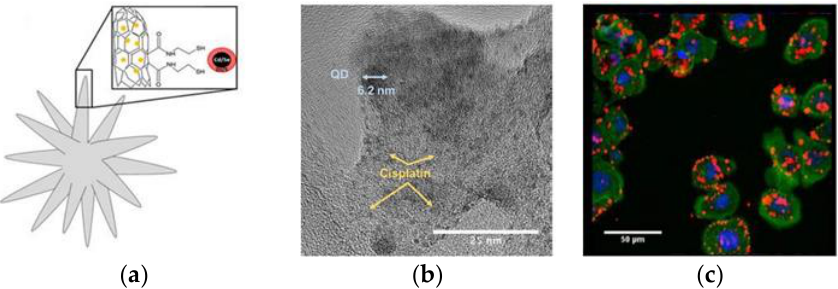
Figure 6. ( a ) Representation of Cisplatin-Carbon Nanohorns/Quantum Dots (CDDP-CNH/CdSe/ZnS QDs); ( b ) TEM images of CDDP-CNH/CdSe/ZnS QDs; ( c ) Internalization of CDDP-CNH/CdSe/ZnS QDs in AY-27 cells. Reproduced with permission from [113]. Elsevier (2018).